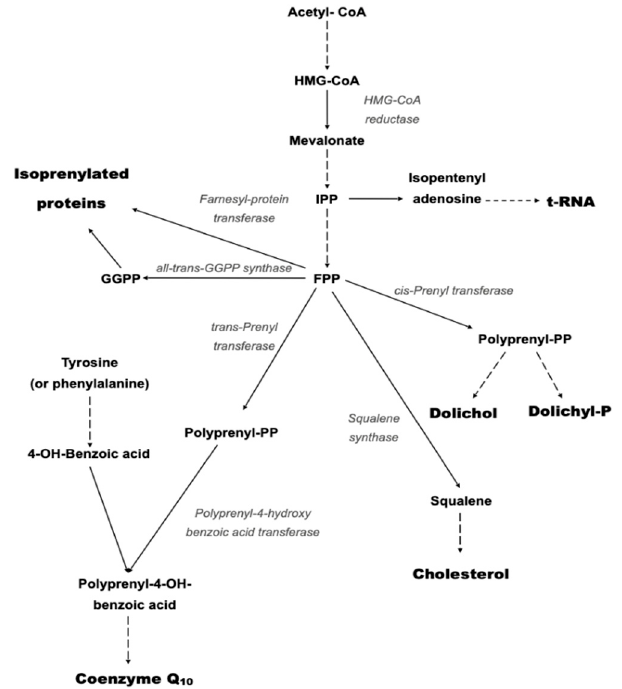
Figure 3. Schematic of the mevalonate pathway responsible for the biosynthesis of CoQ10. Solid arrows represent single biosynthetic reactions; Dashed arrows represent multiple biosynthetic reactions.